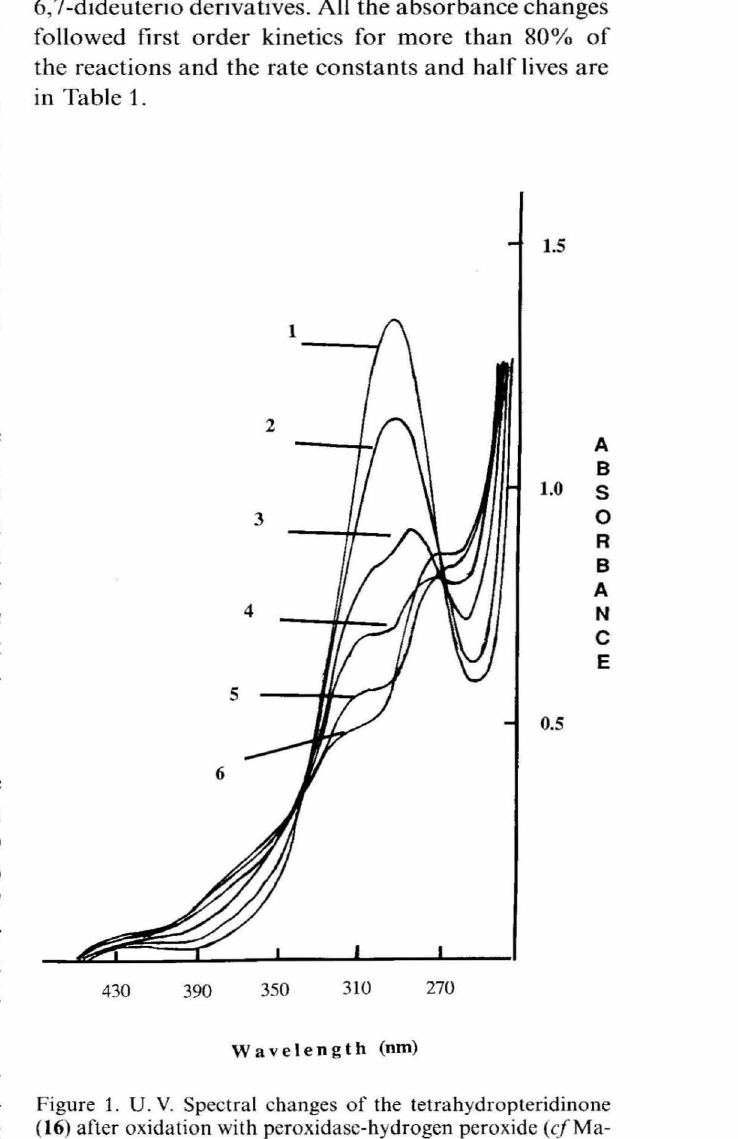
Figure 1. U. V. Spectral changes of the tetrahydropteridinone (16) after oxidation with peroxidase-hydrogen peroxide «(.:fMa terials and Methods) in Tris/Hel buffer pH 7.4 and 25 °C. (1) Immediately after mixing, (2), (3), (4), (5) and (6) after 5, 40. 80. 95 min and 3.5 h